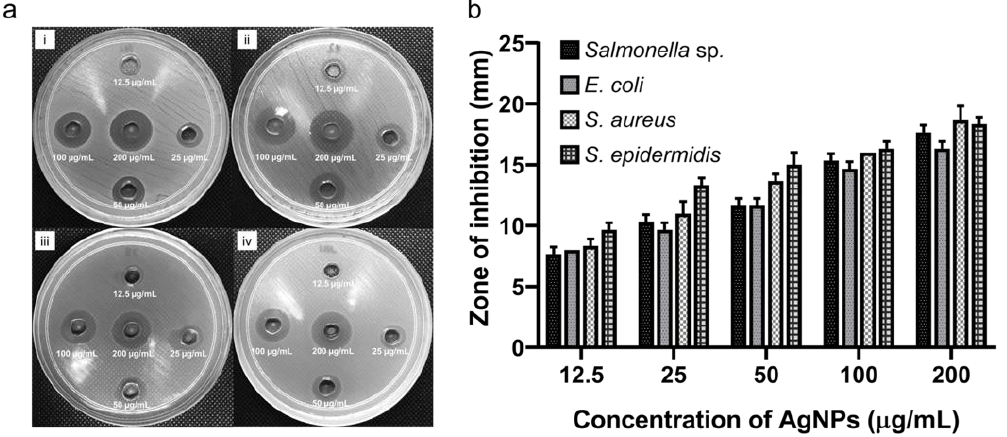
Figure 7. ( a ) Antibacterial activity of biosynthesized AgNPs using agar well di ff usion method against (i) S. aureus , (ii) S. epidermidis , (iii) E. coli , and (iv) Salmonella sp. ( b ) Zone of inhibition of biosynthesized AgNPs at di ff erent concentrations. Each value represents the mean ± SD of three